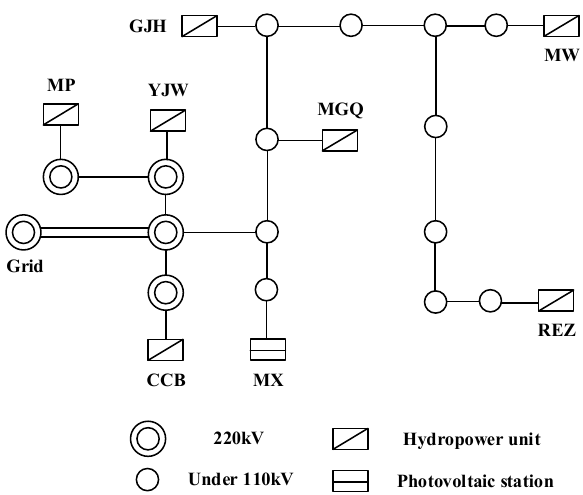
Figure 11. Structure diagram of a county town in China. MP, YJW, CCB, MGQ, GJH, MW, and REZ are the abbreviations for the names of hydropower stations, MX is the abbreviation for the name of a PV station.